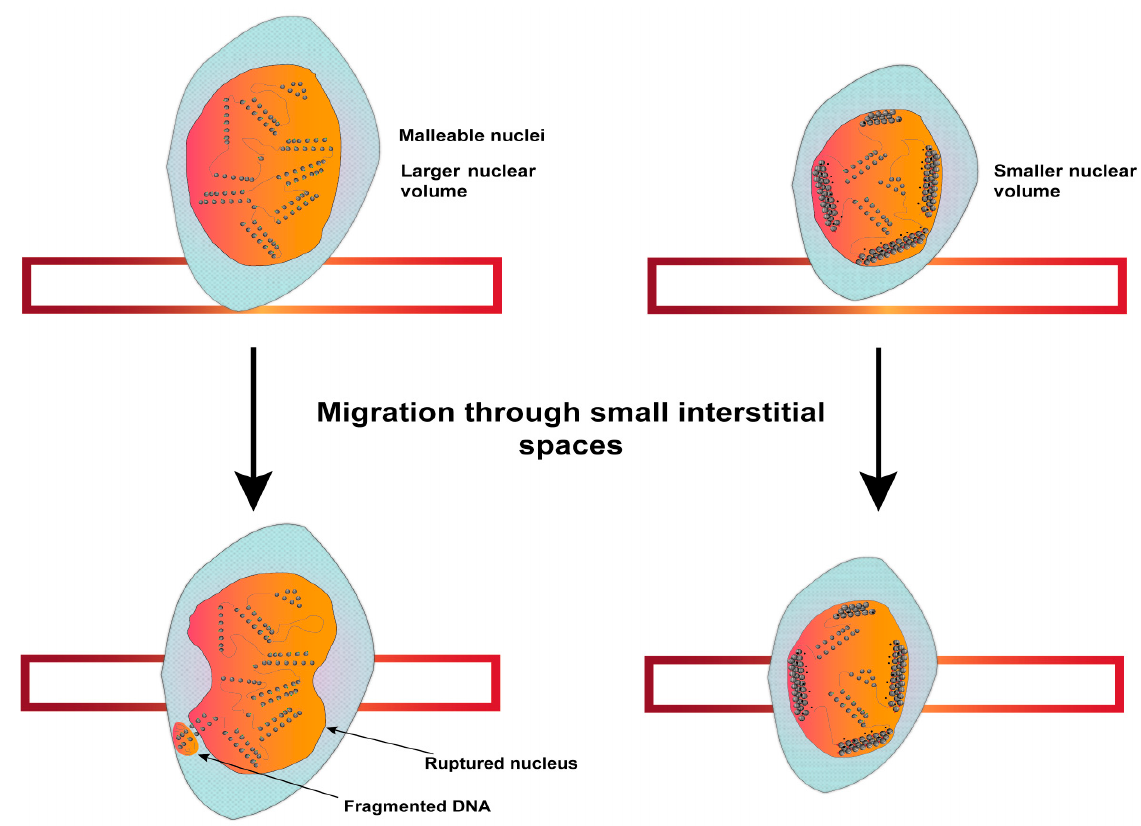
Figure 4. Role of chromatin compaction in maintaining nuclear integrity during metastasis and cellular migration. A schematic of cells migrating through small interstitial spaces in tissue microenvi- ronments with decondensed ( left ) or compacted ( right ) chromatin. The nuclei with decondensed chromatin are larger in volume and prone to ruptures in the nuclear membrane during migration. Higher nuclear rigidity by the compacted chromatin redistributes the shearing stress and resists nuclear membrane ruptures.